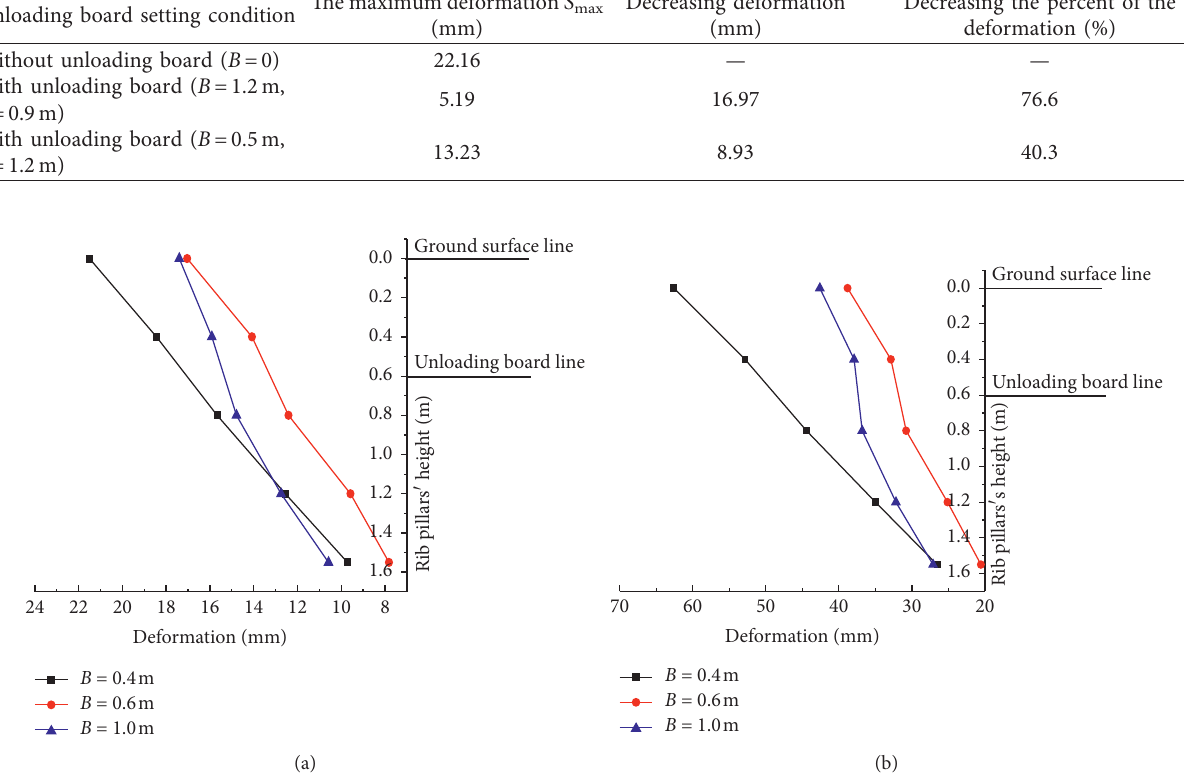
Table 7: Comparison of the maximum deformation of rib pillars with or without the unloading board. Decreasing deformation Decreasing the percent of the The maximum deformation S max Unloading board setting condition (mm) (mm) deformation (%) Without unloading board ( B � 0) 22.16 — —